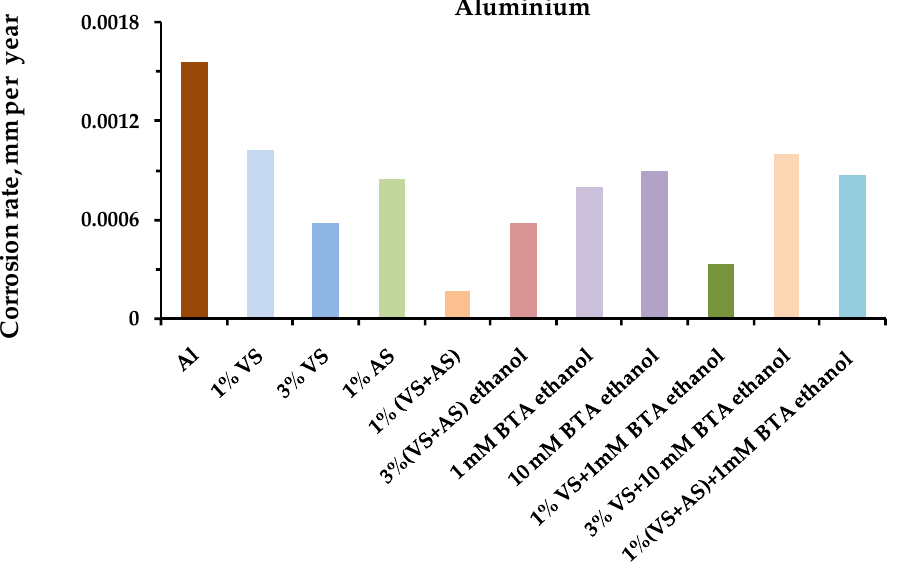
Figure 3. Atmospheric corrosion rates (mm per year) of zinc modified by organosilane-based compositions. Full-scale, one-year corrosion tests, carried out in an urban atmosphere. Gravimetric assessment of corrosion magnitude.